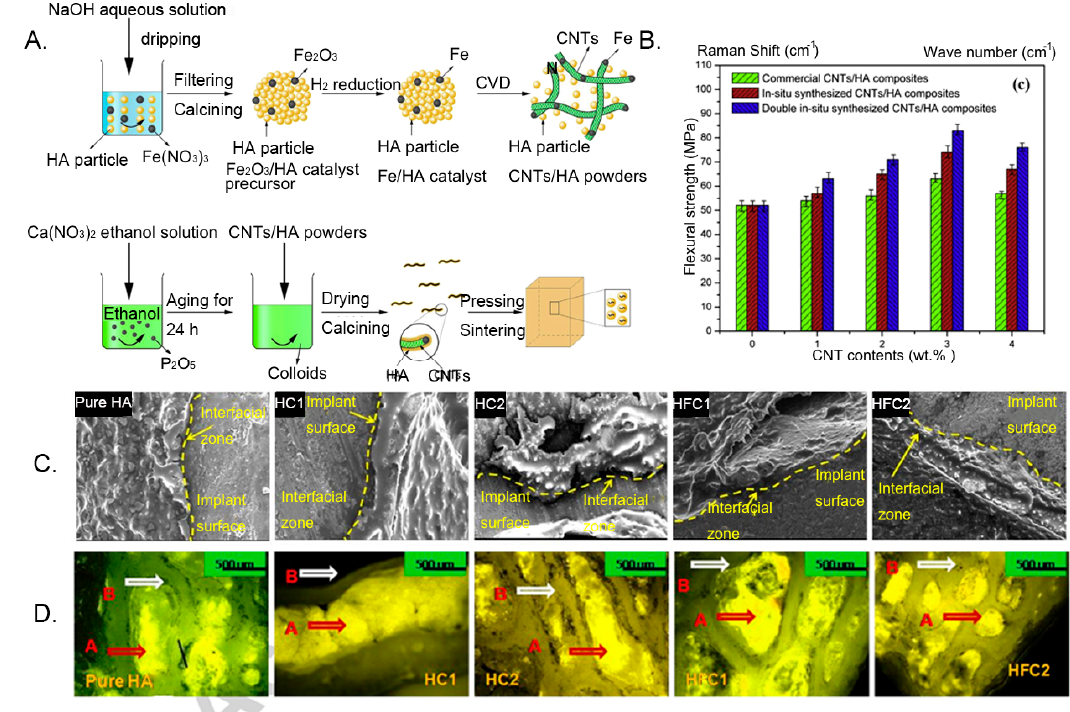
Figure 2. Optimized bioavailability of a carbon nanotube–hydroxyapatite (CNT-HA) composite in bone engineering. ( A ) Schematic diagram of the preparation process of the CNT–HA composite. ( B )